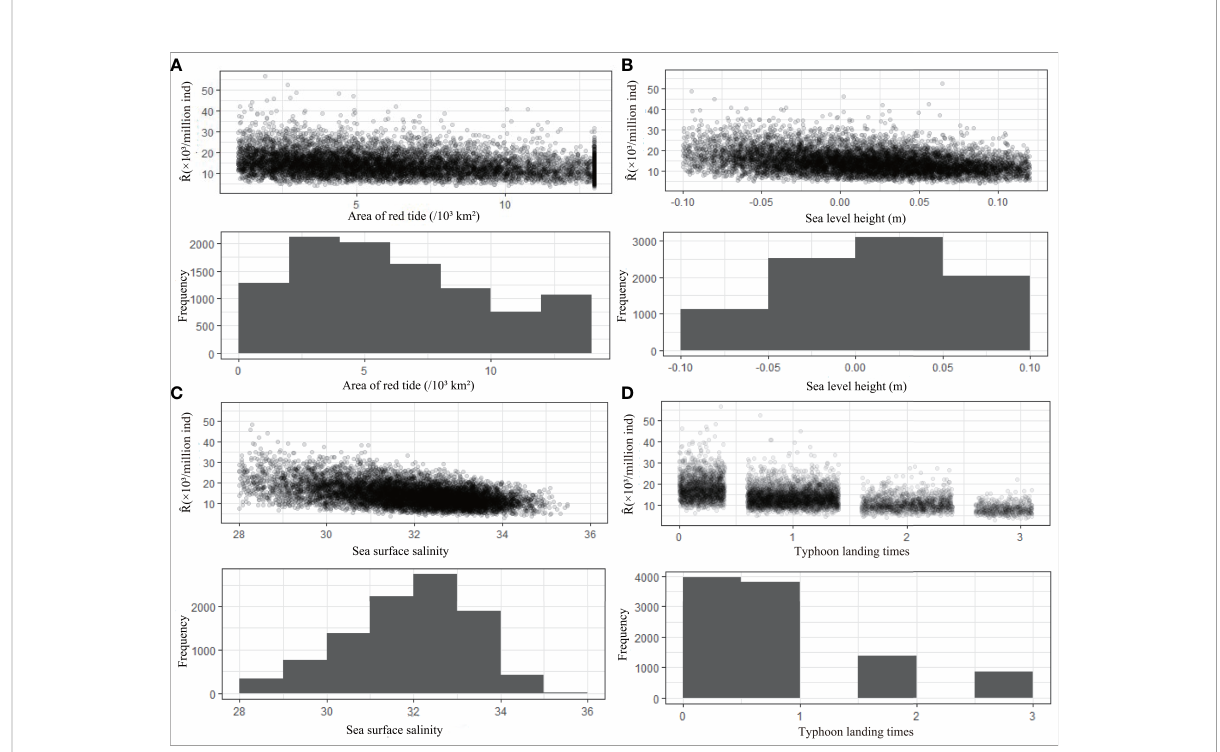
FIGURE 6 Frequency distribution histogram of the simulation results of environmental factors and the scatter plot between environmental factors and Ȓ (Predicted value of recruitment). It describes the frequency of environmental factors area of red tide (A) , sea level height (B) , sea surface salinity (C) , typhoon landing times (D) in different groups, and the responses of Ȓ under varying degrees of changes in each environmental